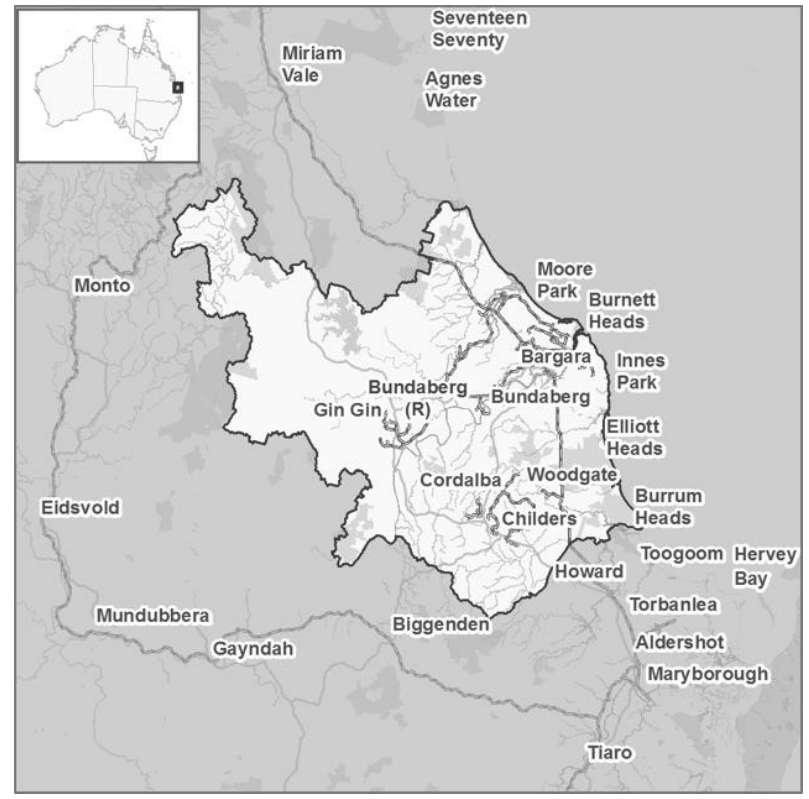
Figure 1. Map of study area, Bundaberg, Queensland.